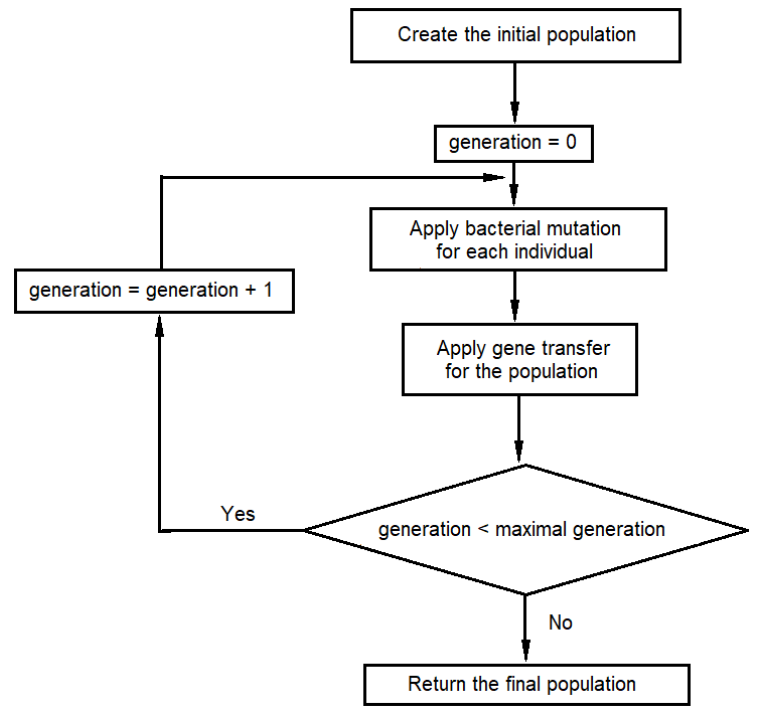
Figure 9. Bacterial evolutionary